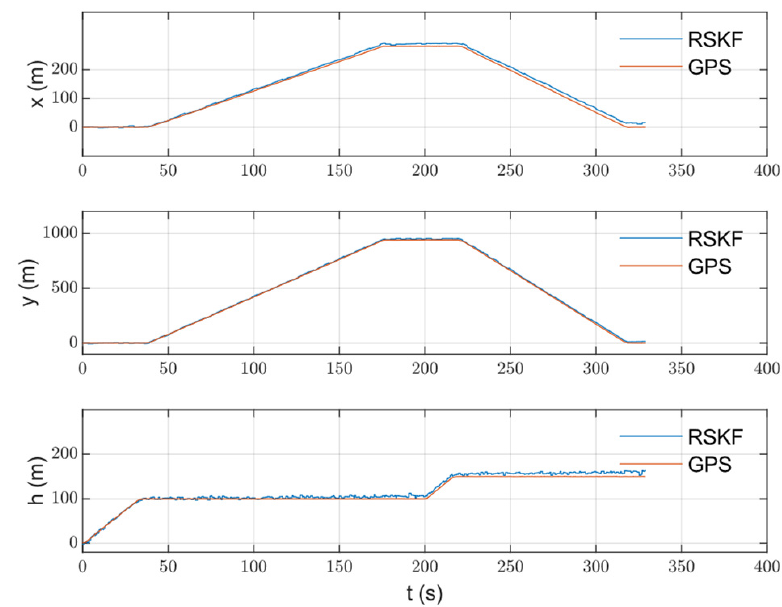
Figure 8. The calculated integrated navigation horizontal path using RSKF with the reference hori- zontal path. The closed path in the horizontal plane is a good indicator of the INS drift compensa- tion.